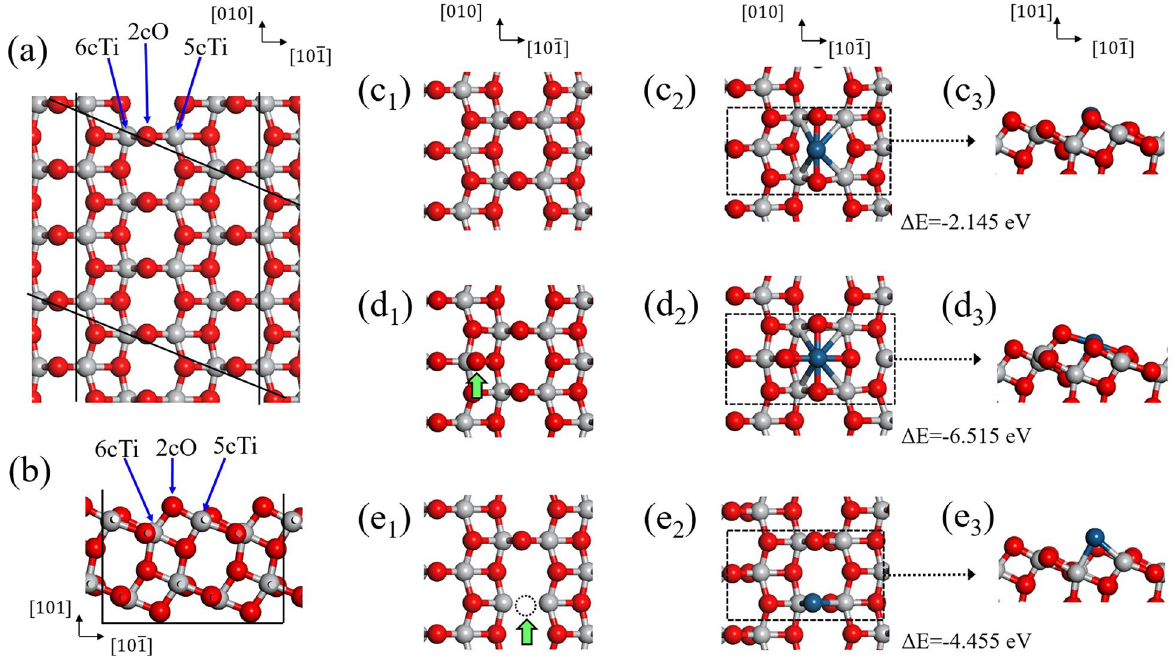
Figure 6. ( a ) and ( b ) Top and side views of anatase TiO 2 (101) surface, respectively. Top views of ( c 1 ) bare– TiO 2 (101), ( d 1 ) oxidized–TiO 2 (101), and ( e 1 ) reduced–TiO 2 (101) surfaces, respectively. The green vertical arrows in ( d 1 ) and ( e 1 ) indicate added (oxidized–TiO 2 ) and removed (reduced–TiO 2 ) O atoms, respectively. DFT calculation results with a Pt adatom on ( c 2 ) bare–TiO 2 (101), ( d 2 ) oxidized–TiO 2 (101), and ( e 2 ) reduced– TiO 2 (101) surfaces, respectively. ΔE is the total energy change due to a Pt adatom, and it is described in the text. ( c 3 ), ( d 3 ), and ( e 3 ) are the side views of ( c 2 ), ( d 2 ), and ( e 2 ), respectively. The gray, red, and blue symbols are Ti, O, and Pt atoms,